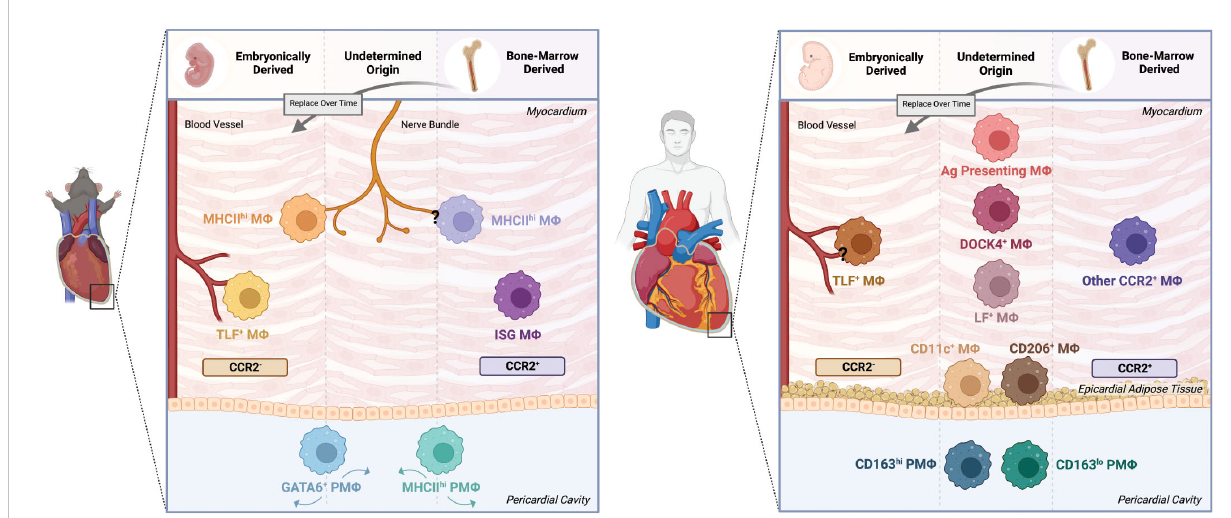
FIGURE 1 Cardiac and pericardial macrophage populations in mice and humans. The macrophage lineage has been established to give rise to heterogeneous populations. As such, this heterogeneity applies to both cardiac macrophage (M F ) and pericardial macrophage (PM F ) populations in the mouse and human contexts. In mice, lineage tracing techniques have identi fi ed embryonically-derived and bone marrow-derived cardiac M F populations. Embryonically-derived cardiac M F include CCR2 + MHC hi and CCR2 + TimD4 + Lyve1 + FolR2 + (TLF + ) populations localized around nerve bundles and blood vessels, respectively. Bone marrow-derived populations include the nerve bundle localized CCR2 - MHC lo M F and the CCR2 - ISG M F . The pericardial cavity in mice is also a niche of unique macrophage populations, speci fi cally GATA6 + and MHC hi PM F . However, the origin of these cells have yet to be con fi rmed. In humans, identifying the phenotype, origin and localization of macrophages becomes more dif fi cult. Similar to mice, humans have comparable embryonically-derived perivascular CCR2 - TLF + M F and bone marrow-derived CCR2 + M F . Yet, while other transcriptionally and functionally unique populations have been identi fi ed, their origins and localizations remain uncertain. These populations include but not limited to DOCK4 + , Lyve1 + FolR2 + (LF+), and Antigen (Ag) Presenting M F . Likewise, PM F of undetermined origin also exist, dichotomized into CD163 hi and CD163 lo populations. The epicardial adipose tissue in humans is also home to M F subsets broadly characterized as CD11c + and CD206 + populations. Created with